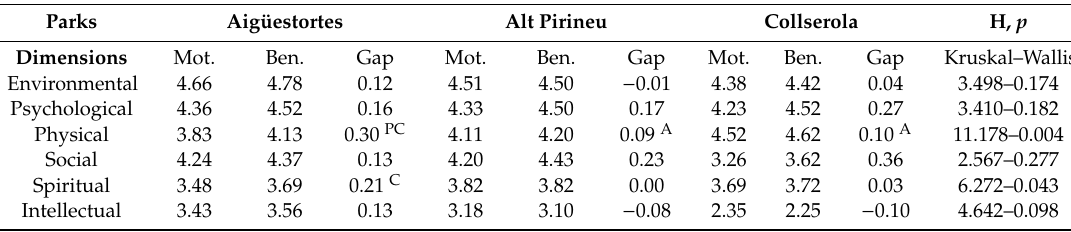
Table 7. Results from the gap